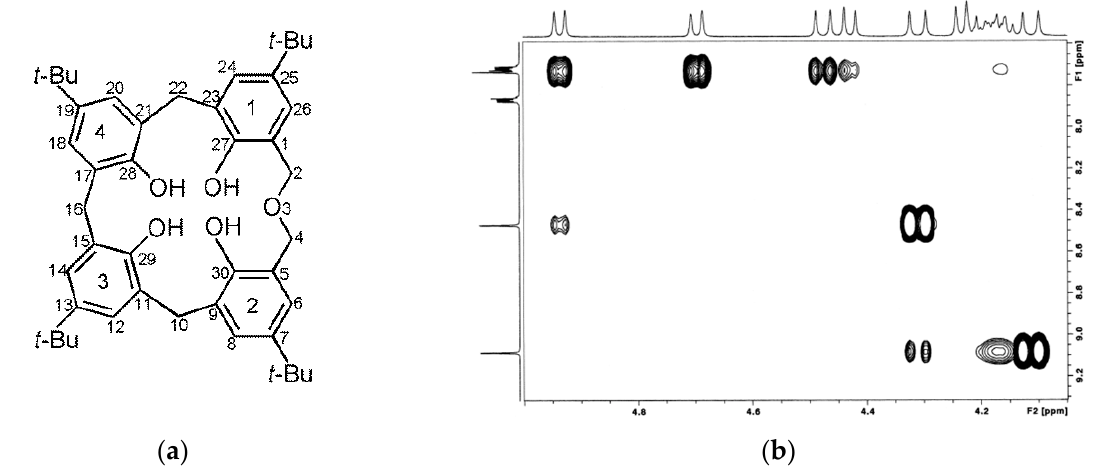
Figure 2. ( a ) Chemical structure of 1 with carbon atoms numbering; ( b ) Section of the NOESY spectrum of 2a (500 MHz, CDCl 3 , 22 °C).